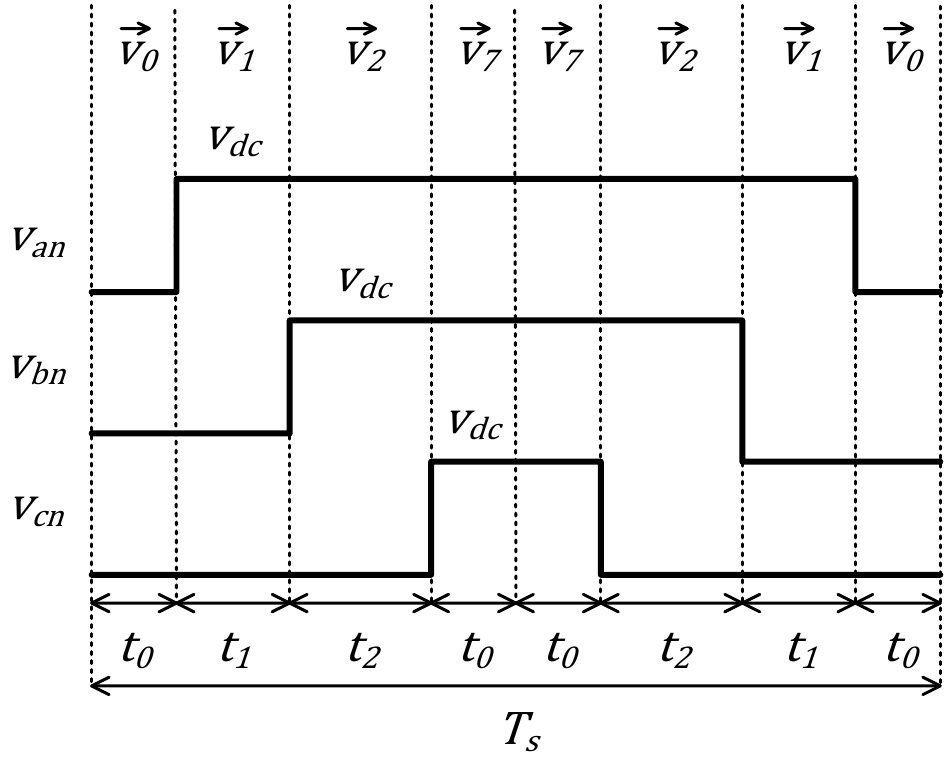
Figure 4. Seven-segment switching sequence for sector one.